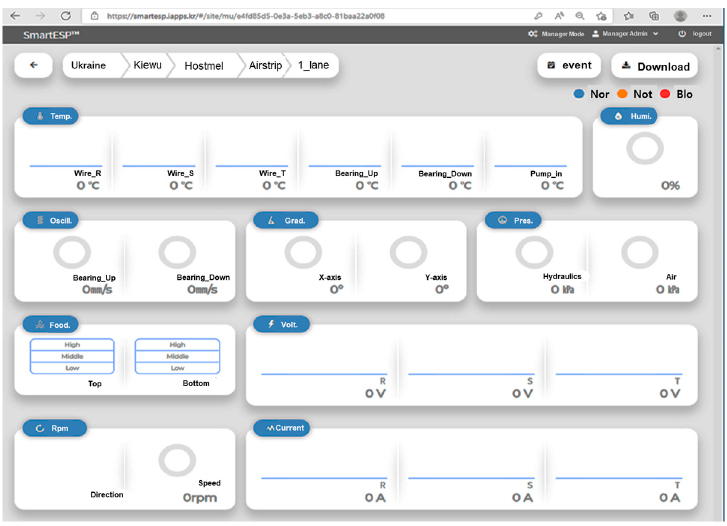
Figure 5. Monitoring system configuration screen of server computer.